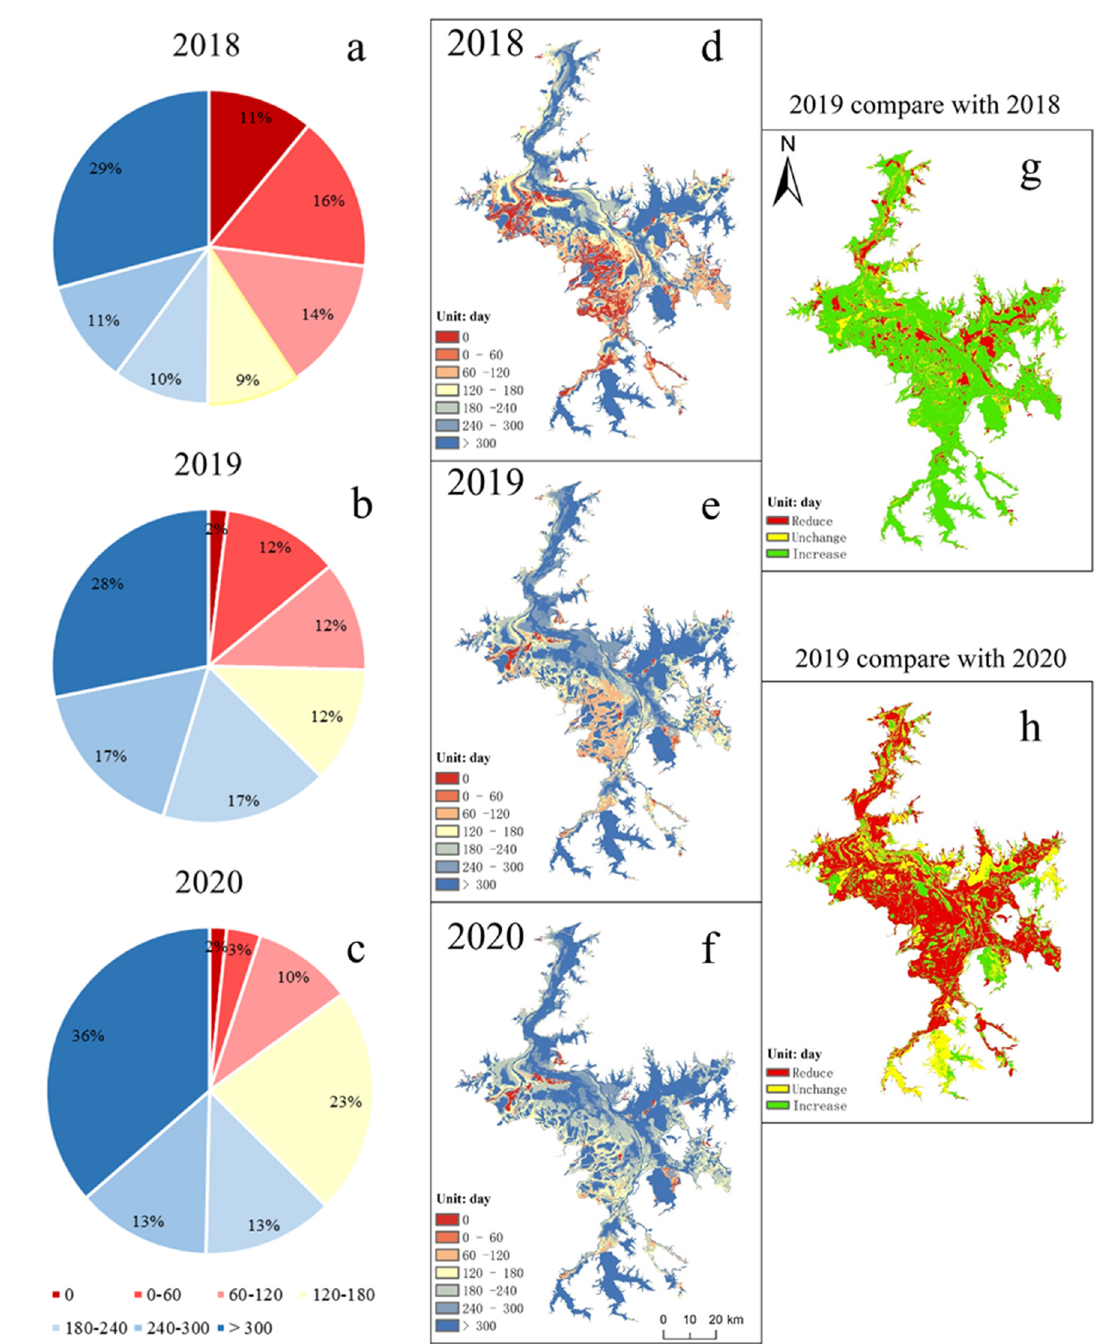
Figure 5. ( a – c ) Areas of different flood duration (FD) values (percentage) for 2018 to 2020. ( d – f ) Spatiotemporal distribution of the FD from 2018 to 2020. ( g ) FD spatiotemporal pattern changes from 2018 to 2019. ( h ) FD spatiotemporal pattern changes from 2019 to